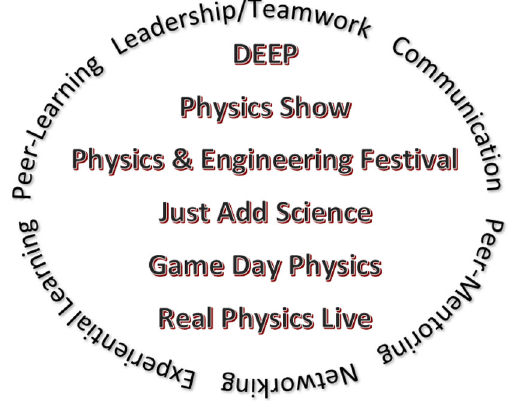
FIG. 1. Schematic of the program principles and their asso- ciated informal physics programs at Texas